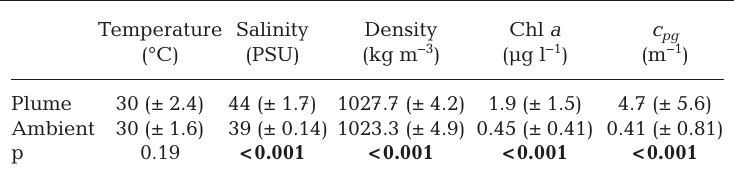
Fig. 3. Mean (solid line) and SD (shaded area) plotted for (a) potential temperature, (b) practical salinity, (c) chlorophyll a concentration de- rived from fluorescence, and (d) beam attenuation coefficient ( c pg ). Data were collected at Stns P1 (red) and E (black) from January 2014 to Janu- ary 2015. No fieldwork was conducted in October, which resulted in a gap in data for all 4 variables above. In addition, the laser diffractometer (LISST) was not deployed in July for logistical reasons, resulting in a gap in Table 1. Salinity, density, chlorophyll a , and the beam attenuation coefficient ( c pg ) of the discharge water (Stn P1) compared to the ambient coastal reef water at Stn E (see Fig. 1 for station locations), given as mean ± SD. Significant differences between plume and ambient water (p < 0.05) are shown in bold